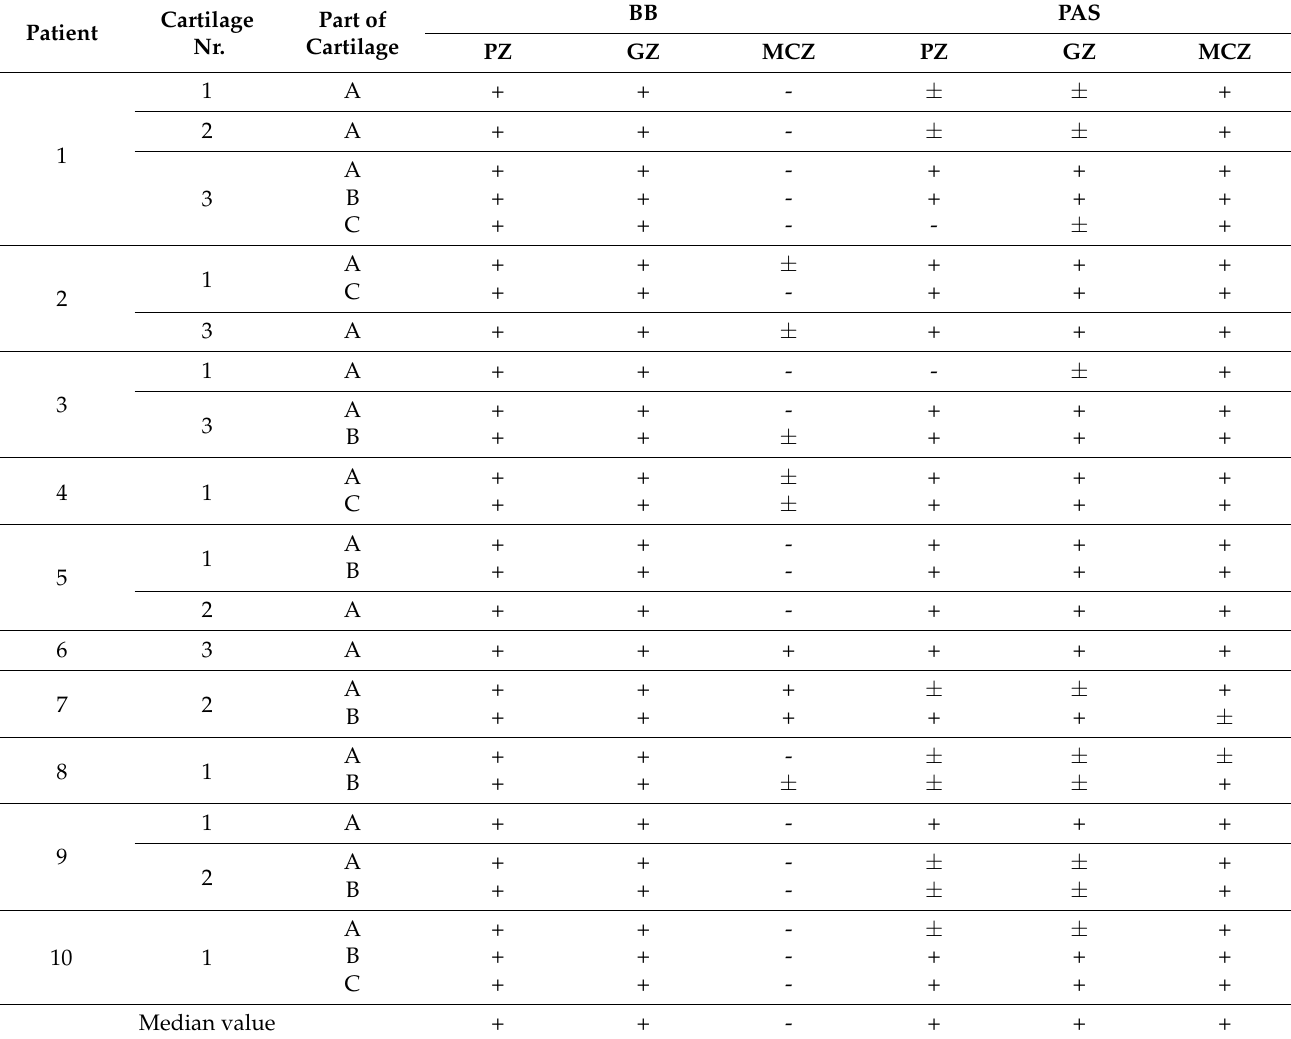
Table 1. Distribution and appearance of extracellular matrix positives for Bismarck brown and PAS staining in healthy tracheal hyaline